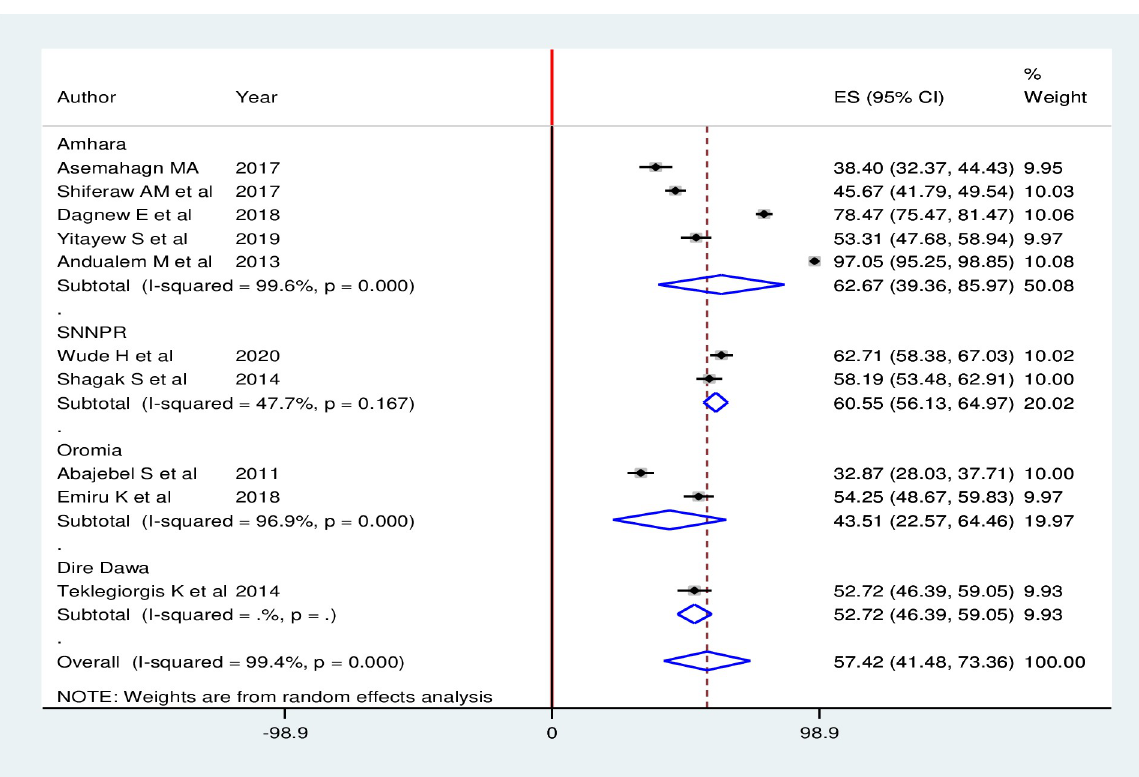
Fig 3. Subgroup analysis (by region) of studies included in meta-analysis on utilization of routine health information among health workers in Ethiopia, 2020.